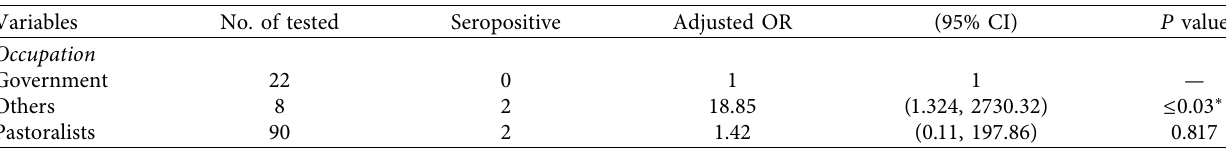
Table 5: Multivariable Firth’s bias-reduced logistic regression analysis of factors associated with brucellosis seropositivity in humans.